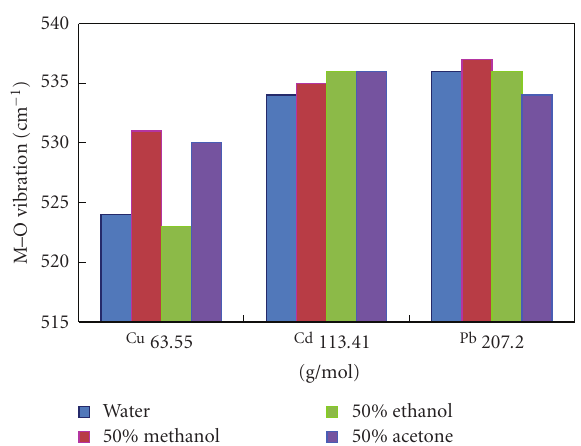
Figure 6: Change in M–O vibrations with atomic mass.